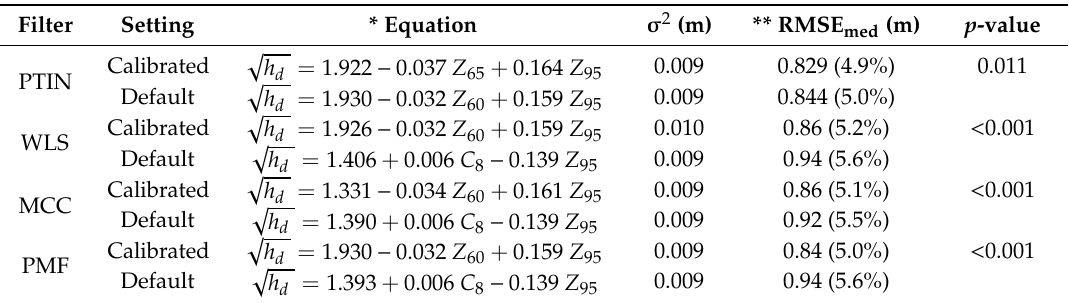
Table 5. Dominant height equations with their associated variances ( σ 2 ), and the p -value for the Wilcoxon–Mann–Whitney test obtained with di ff erent settings of the progressive triangulated irregular network (PTIN), weighted linear least-squares interpolation (WLS), multiscale curvature classification (MCC), and progressive morphological filter